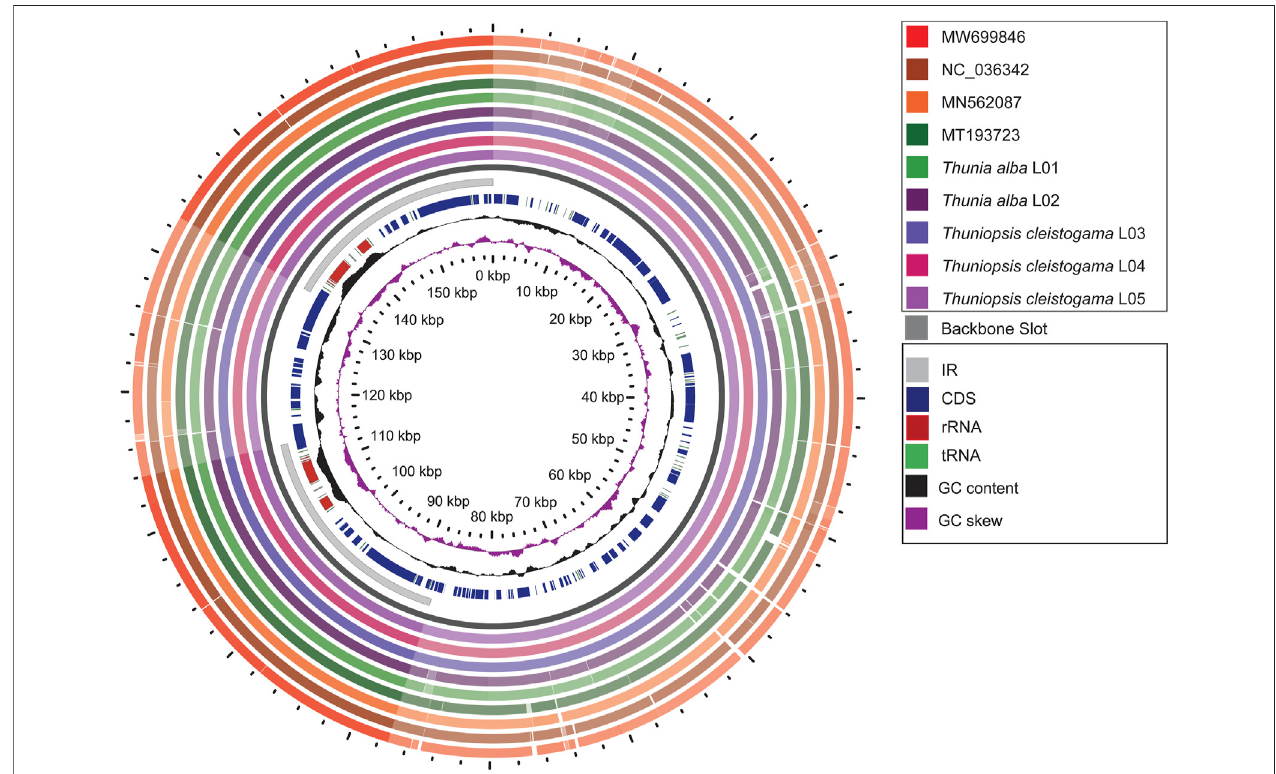
FIGURE 4 | Graphical map shows nine circular plastome assemblies using Thuniopsis cleistogama _L04 plastome alignment as a reference. The innermost ring showsthegenomesizeinkbp,followedbyGCskew(purple)andGCcontent(black).TheremainingringsdenoteBLASTcomparisonsofplastomesequences.Fromthe inner to outer: Thuniopsis cleistogama _L05, Thuniopsis cleistogama _L04, Thuniopsis cleistogama _L03, Thunia alba _L02, Thunia alba _L01, MT193723; MN562087; NC_036342andMW699846.Thesimilaranddivergentlocationsarerepresentedbycontinuousandinterrupted tracklines,respectively.Thelightlyscreenedarea stretching from the inner toward the outer circle marks divergent regions with large sequence